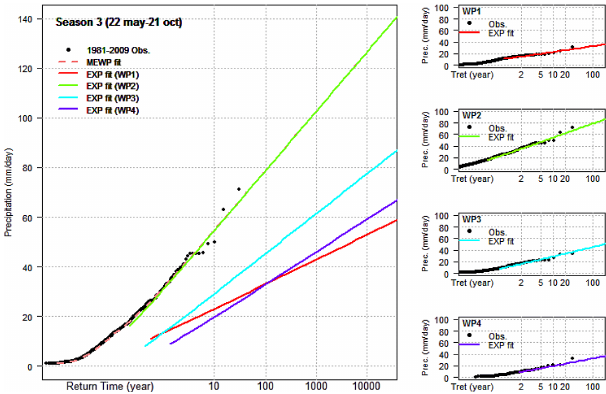
Figure 7. Seasonal MEWP distributions for